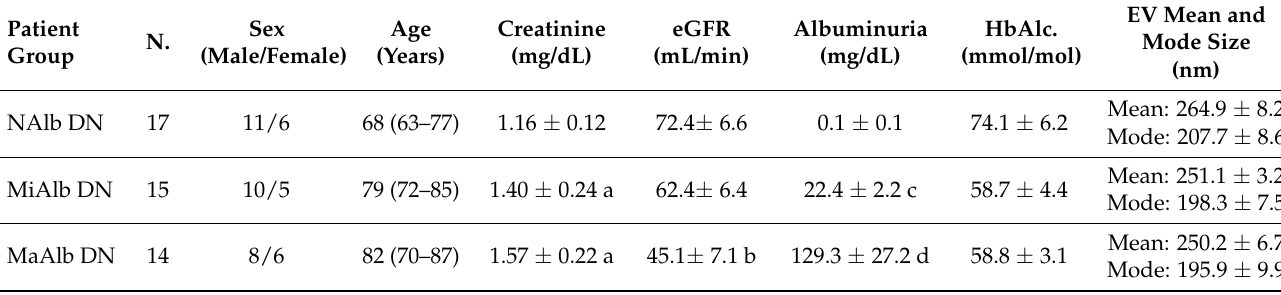
Table 1. Clinical characteristics of diabetic patients.